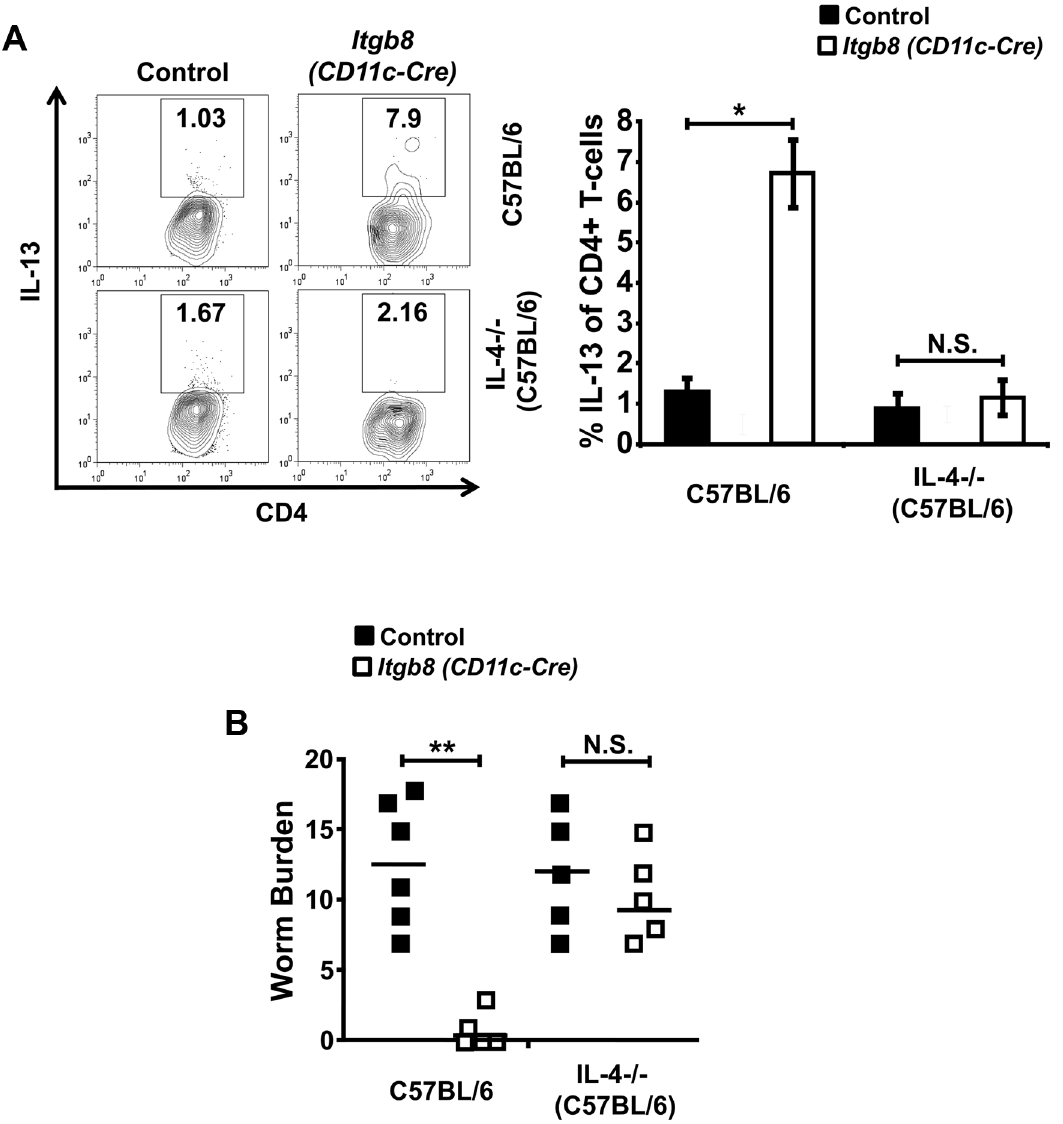
Figure 5. Ablation of enhanced IL-13 production by CD4 + T-cells in Itgb8(CD11c-Cre) mice restores susceptibility to infection with T. muris . ( A ) IL-13 production by LILP CD4 + T-cells isolated day 3 post-infection (p.i.) with a chronic dose of T. muris eggs in IL-4 2 / 2 control and Itgb8 (CD11c-Cre) IL-4 2 / 2 mice. Representative flow cytometry plots and mean data are displayed. Data (n=5–6 mice per group) are from two independent experiments. Data (n=5–6) are from two independent experiments performed. ( B ) Worm burdens from IL-4 2 / 2 and Itgb8 (CD11c-Cre) IL-4 2 / 2 mice at day 14 p.i. with a chronic dose of T. muris eggs. Data (n=5–6 mice per group) are from two independent experiments. **, P , 0.01; N.S., not significant via Student’s t –test for the indicated comparisons between groups, error bars represent SE of means.